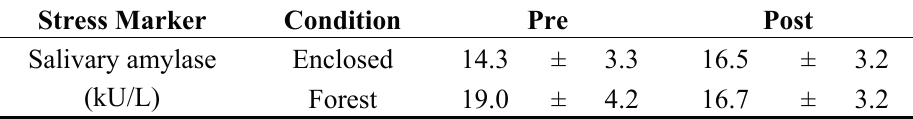
Table 3. Salivary amylase changes in the Enclosed and Forest